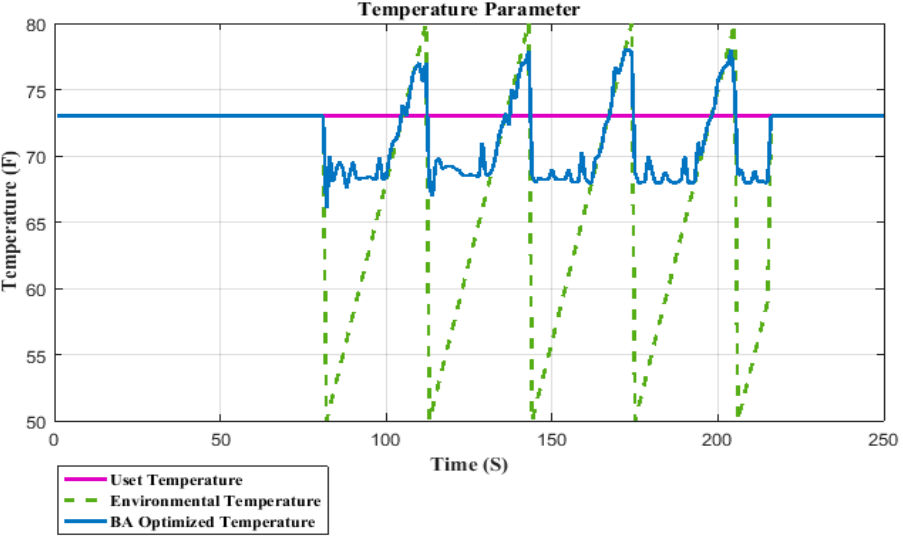
Figure 5. User set parameter, environmental parameter and BA optimize temperature values.